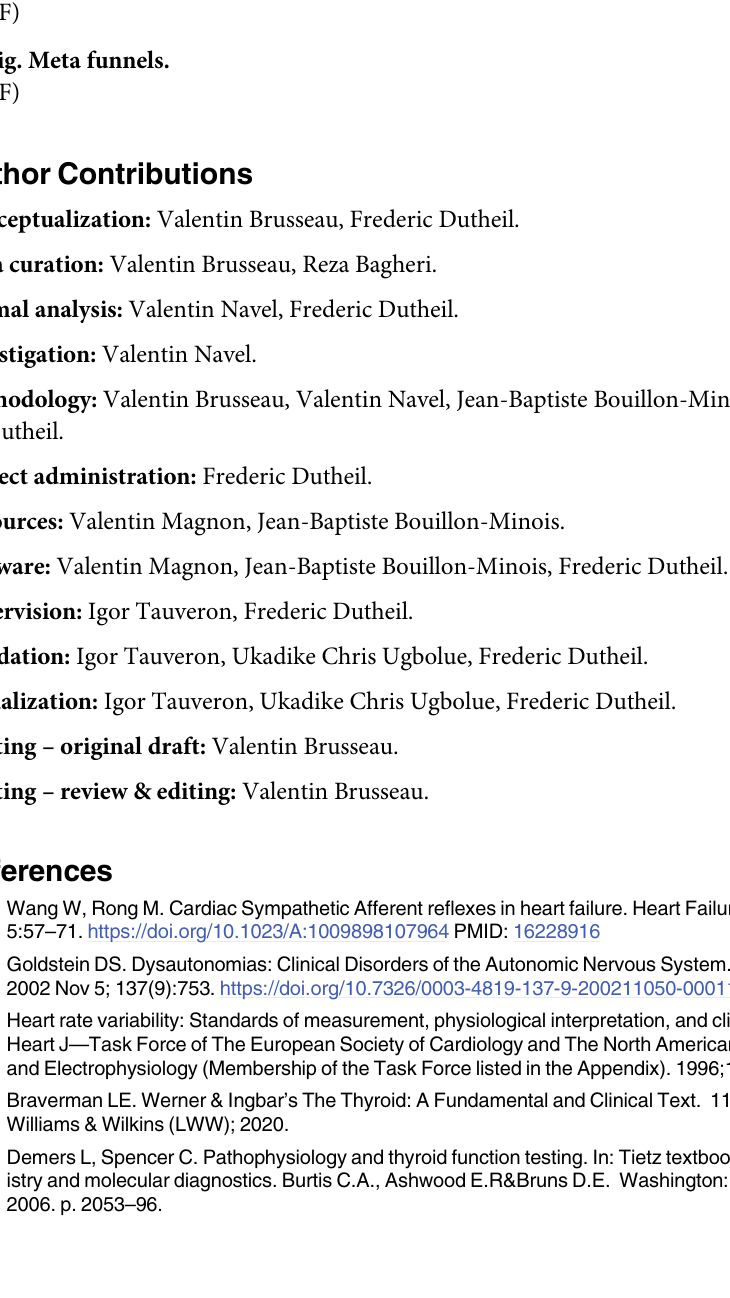
S3 Fig. Aims of included articles, quality of articles, inclusion and exclusion criteria of included studies, characteristics of population, characteristics of hypothyroidism, and HRV measurements and analysis. S4 Fig. Detailed meta–analyses in untreated hypothyroid patients compared with controls for each HRV parameters: RR intervals, SDNN, RMSSD, pNN50, TP, LF, HF, LF/HF. (TIFF) S5 Fig. Detailed meta-regressions of factors influencing HRV parameters. (TIFF) S6 Fig. Meta